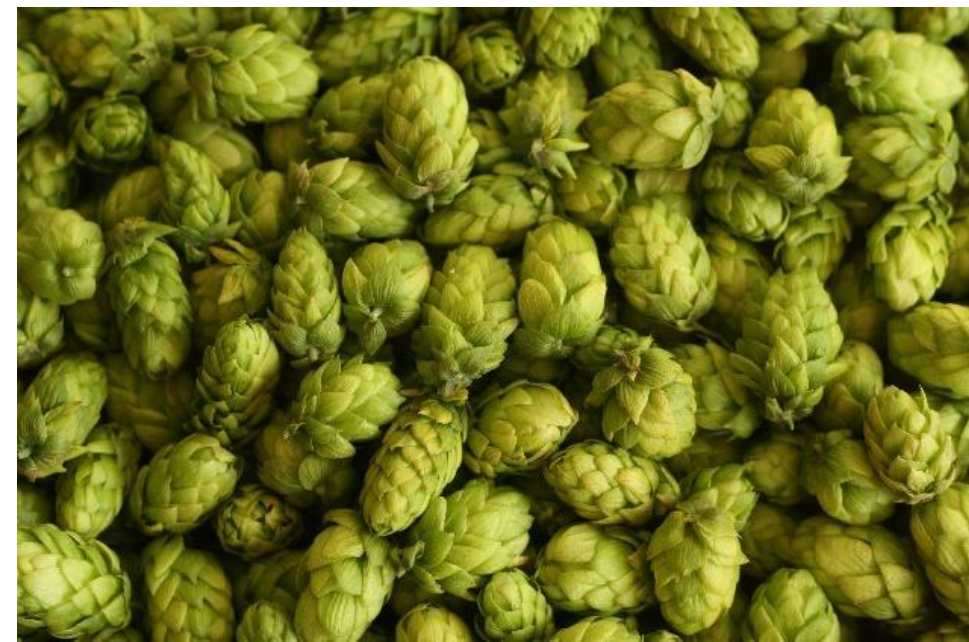
Figure 1. Figure of hop ( Humulus lupulus L .) cones.